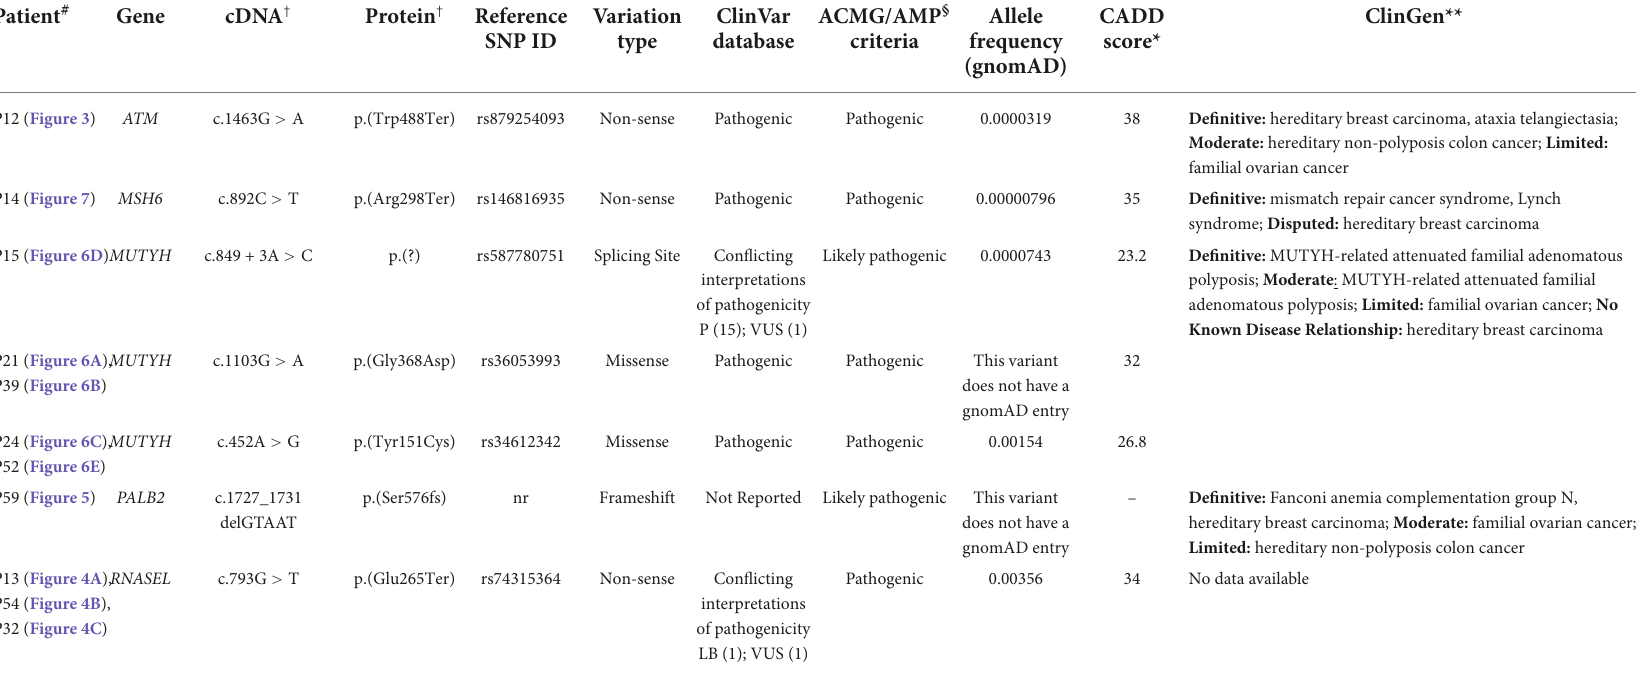
TABLE 3 Pathogenic variants found in genes different from the